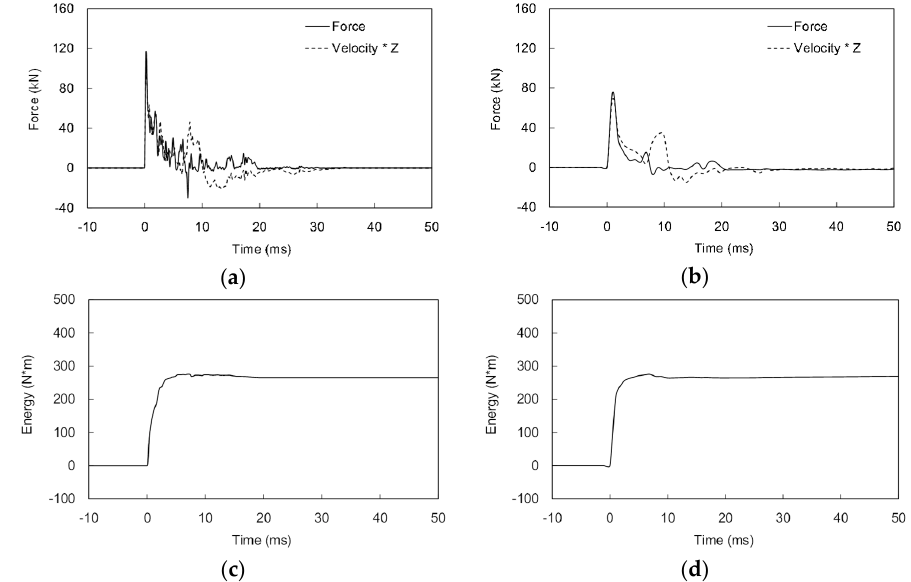
Figure 12. Comparison of the dynamic measurements: ( a ) force and velocity at the ICP rod head; ( b ) force and velocity at the PDA sensors; ( c ) energy at the ICP rod head; ( d ) energy at the PDA sensors.